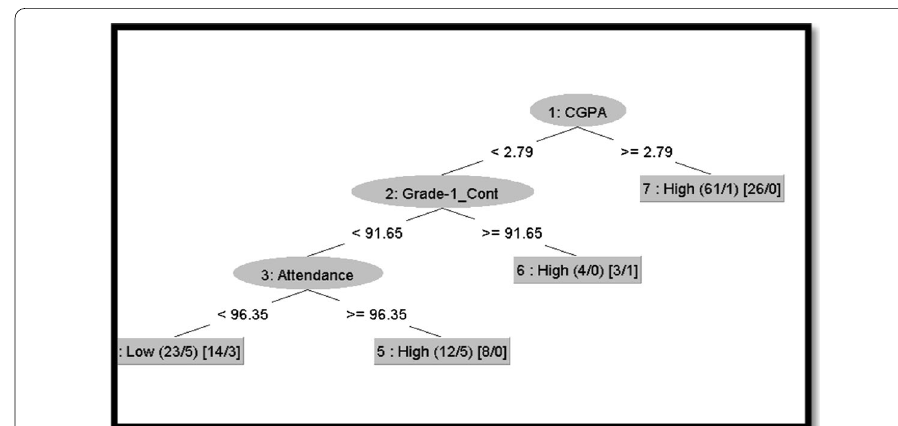
Fig. 6 The decision tree (RepTree) extracted from WEKA